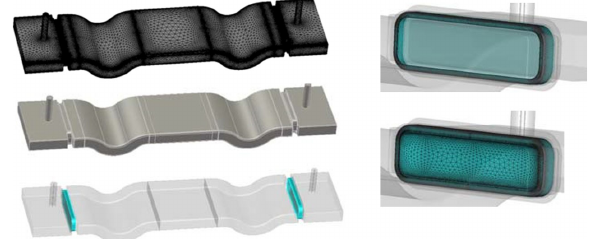
FIG. 7. Various views of the rf model and mesh of the double dogleg and window resonator. The overall number of tetrahedral mesh cells was ∼ 0 . 74 M taking into account one symmetry